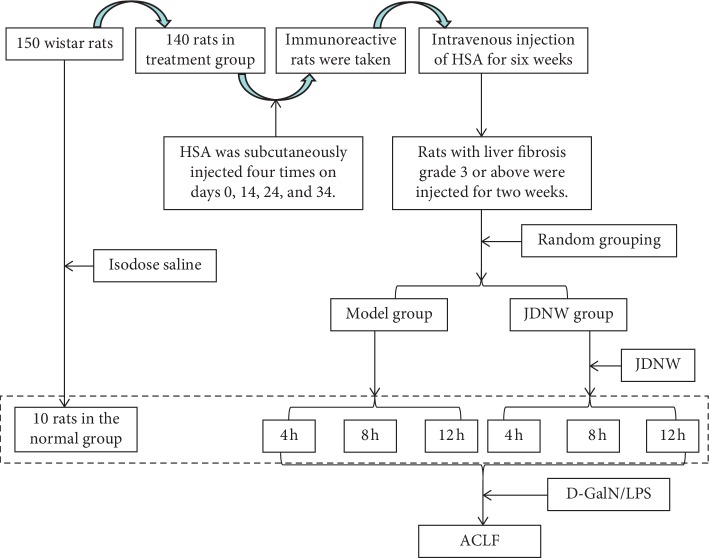
Experimental setup.